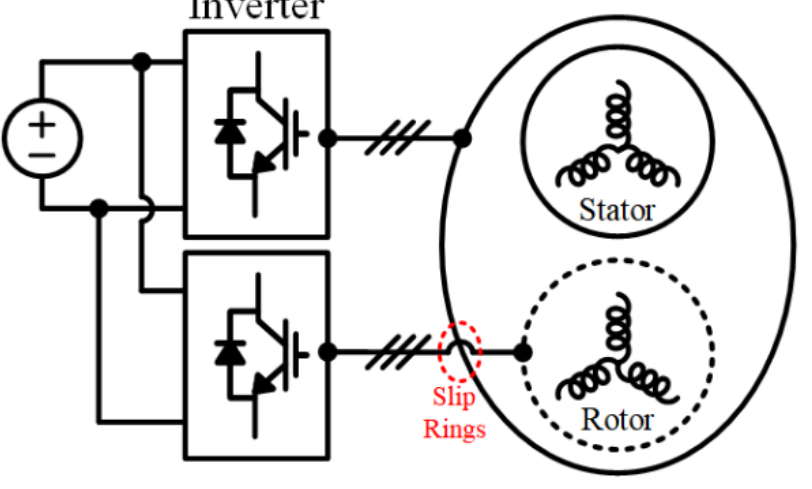
Figure 1. Double inverter-fed wound machine drive system.